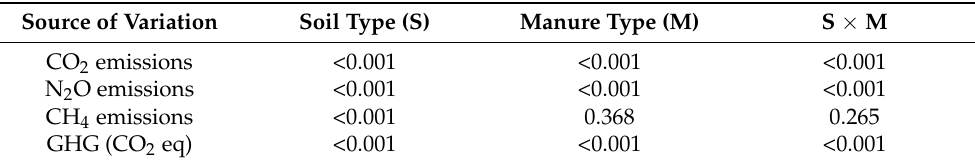
Table 2. Results of two-way ANOVAs ( p -values) testing the effects of soil type, manure type, and their interactions on the cumulative greenhouse gas (GHG) emissions ( n = 4). Source of Variation Soil Type (S)